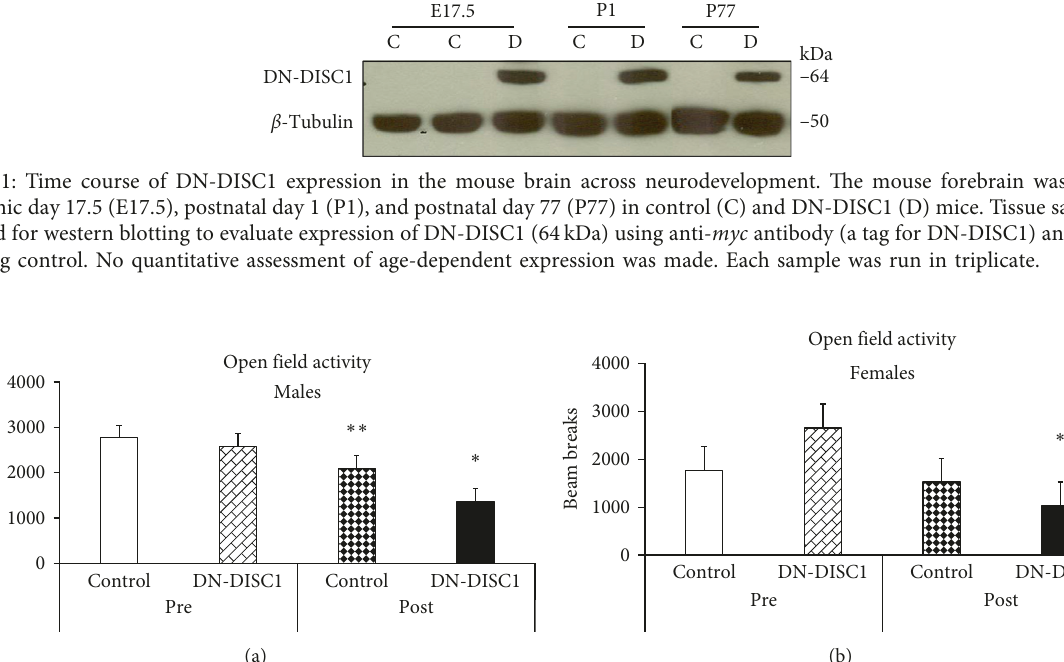
9-10 per group for male mice; n 5 per group for female mice. Two-way ANOVA of the total activity data (cid:31) (cid:31) 11.3, p 0 . 002; and for female mice, F (1,19) (cid:31) (cid:31)